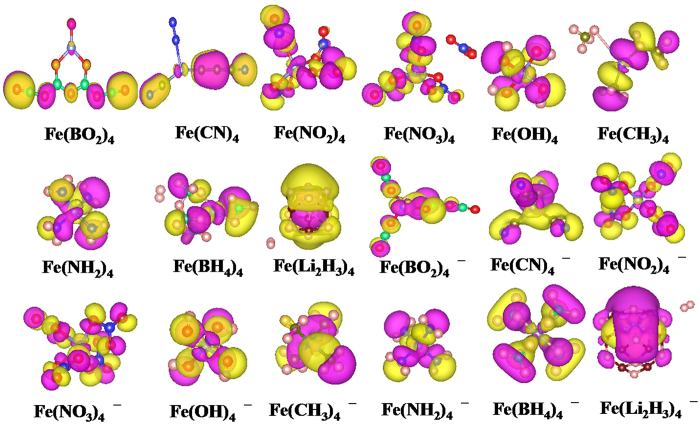
The highest occupied molecular orbitals (HOMOs) of neutral and anionic clusters FeL4 (L = BO2, CN, NO2, NO3, OH, CH3, NH2, BH4 and Li2H3).